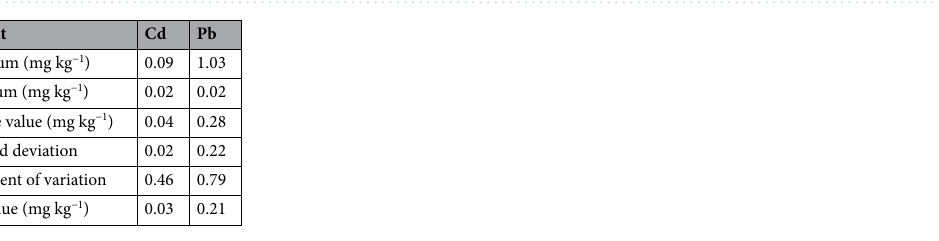
Table 5. Analysis of the available content of Cd and Pb in the soil in Anxin